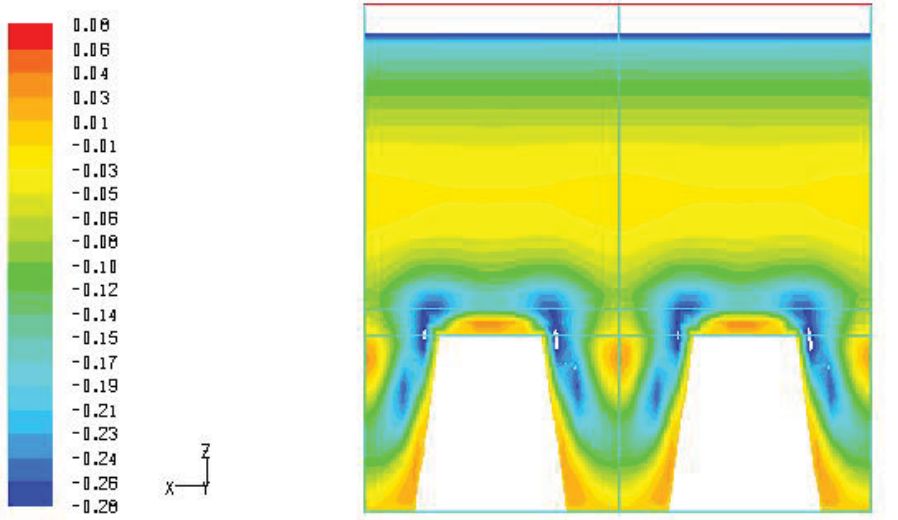
Figure 11: Radial velocity component (z) – cross section through the protrusions (row 2) As the conclusion we can state that the flow field among the elementary protrusions, fixed on the rotating drum surface, is characterized by actual components of the velocity vector. The arising dynamic forces can have some influence on the processed textile layer and on its elementary fibres, too. In such a way, they could have an influence on their usable characteristics,